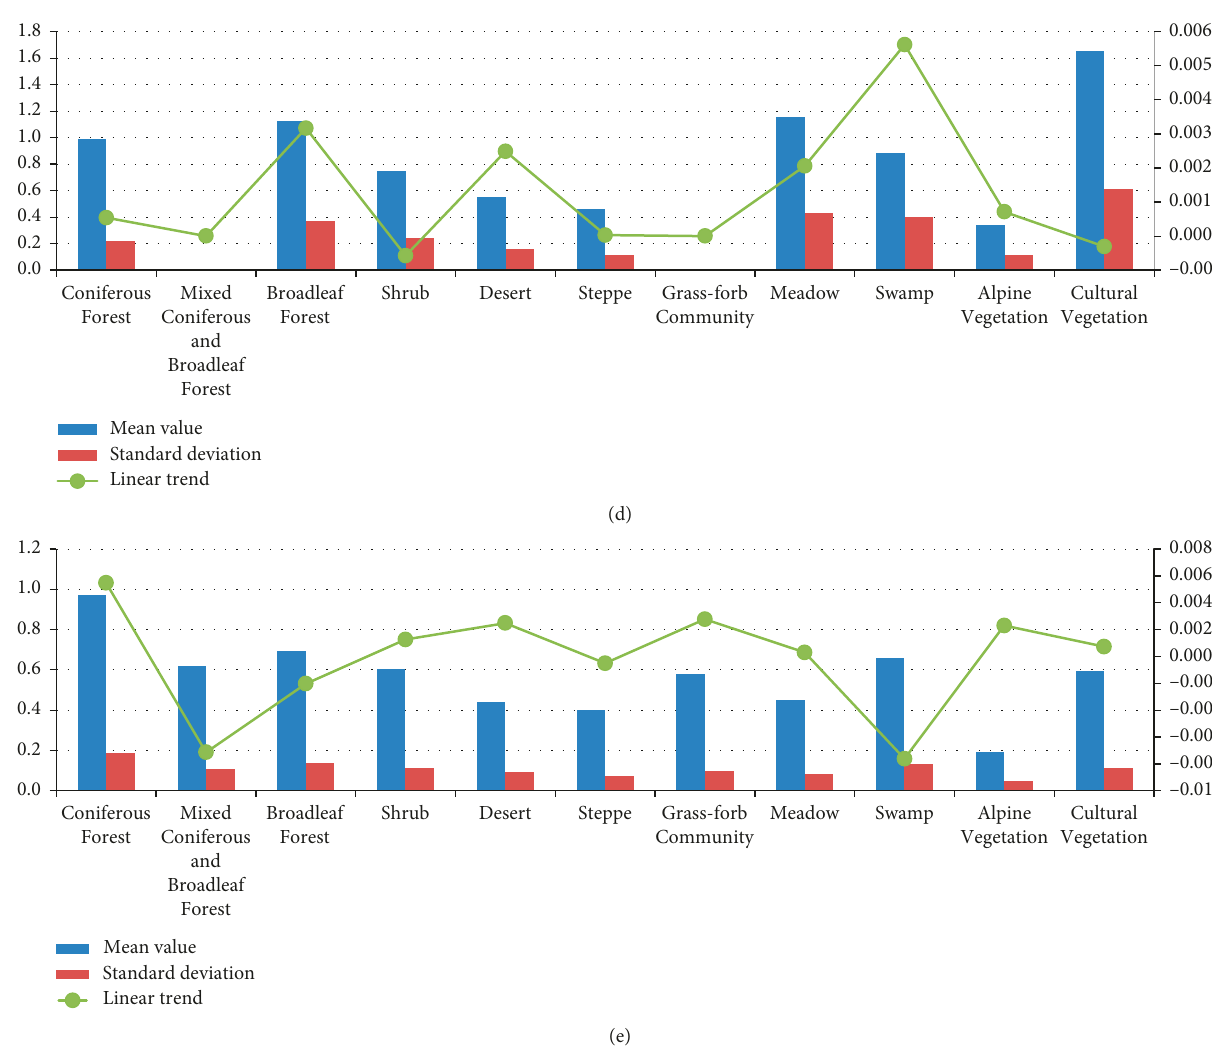
Figure 6: Statistical central tendency of the mean value, standard deviation, and linear trend of vegetative PUE in climate zones from 2000 to 2015: (a) climate zones; (b) humid regions; (c) semihumid regions; (d) arid regions; (e) semiarid